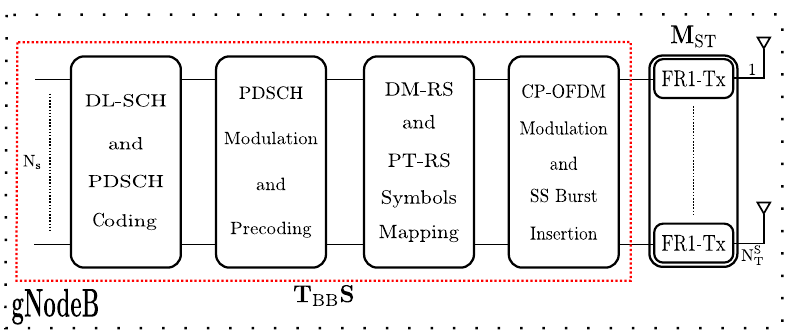
Figure 2. Baseband gNodeB